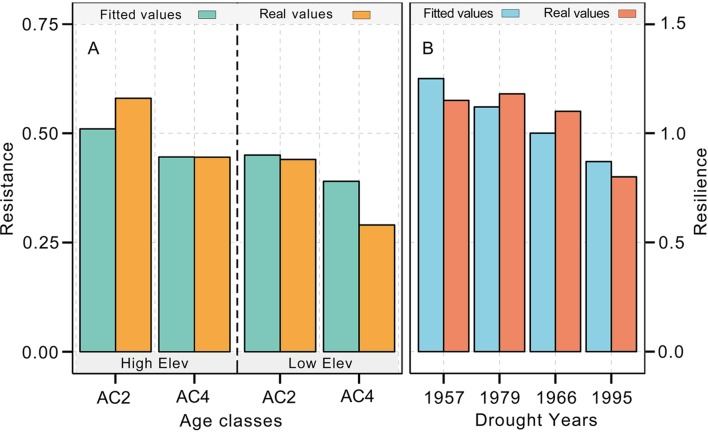
Comparison between the fitted resistance (A) and resilience values (B) and the real values. The regression equation is the generalized linear model generated by the age class 1 (AC1), AC3, and AC5 age groups of Qilian junipers. Please refer to Table 1 and the main body of the text for the specific age classes of Qilian juniper.